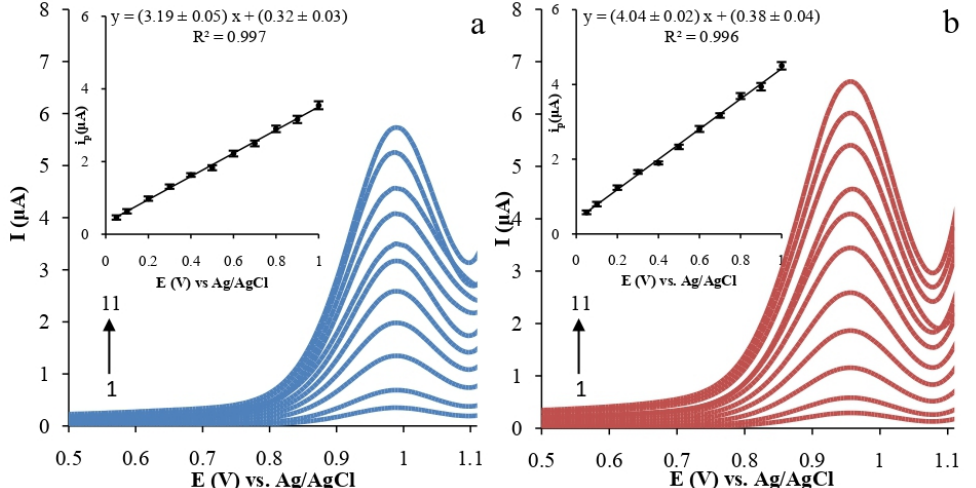
Figure 5. DPV of ( a ) R-Nap and ( b ) S-Nap solutions of various concentrations on GCE/PEC–[Cu( S -Ala) 2 ]–[Cu( S -Phe) 2 ]: 0.05 (1), 0.1 (2), 0.2 (3), 0.3 (4), 0.4 (5), 0.5 (6), 0.6 (7), 0.7 (8), 0.8 (9), 0.9 (10), 1 (11) mM (phosphate buffer solution with pH 6.86, potential scanning rate 0.2 V/s). Insets: the corresponding calibration curves.